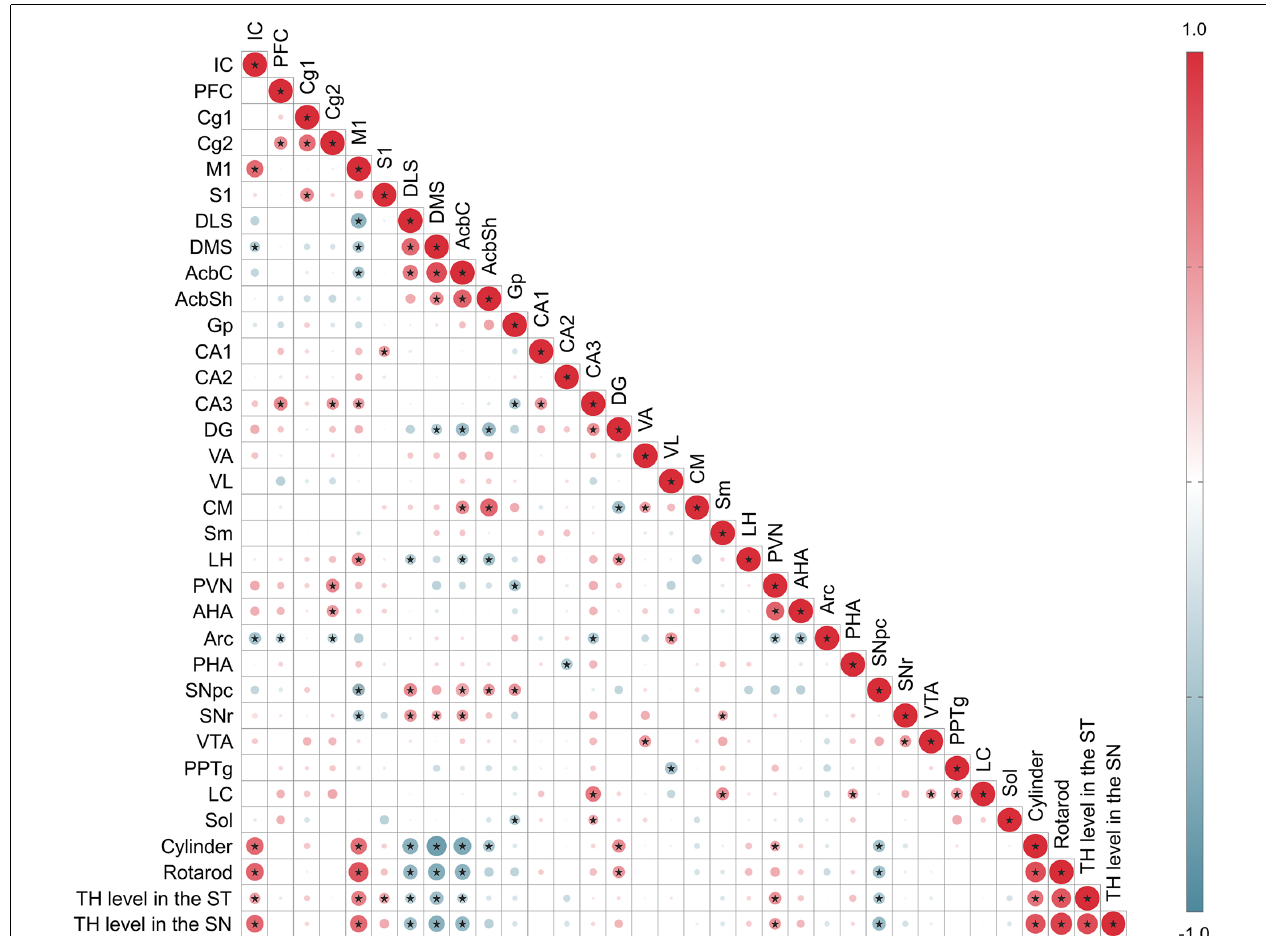
FIGURE 7 | Correlation between c-Fos expression level in 30 regions, motor behavior tests, TH level in the ST or SN. The areas of circles show the value of correlation coefficients. Correlation values are presented in the upper panel in the circle; positive correlations are displayed in red and negative correlations in blue. Color intensity (light to dark) and the size of the circle (small to big) are proportional to the correlation coefficients (0–1 for the positive coefficient and 0 to -1 for negative coefficient) where for example the correlation coefficients on the principal diagonal are equal to 1 (it was represented in dark red and the biggest size of circle). Black stars indicate significant correlations ( p <